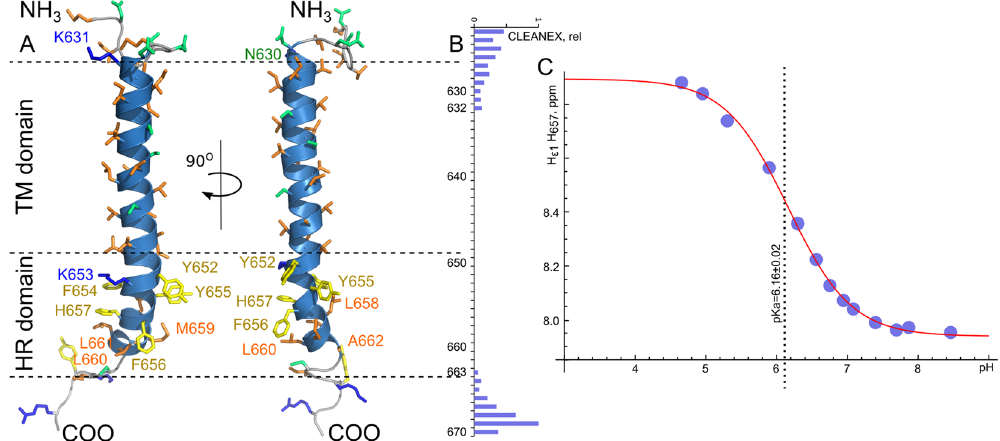
Figure 2. Spatial structure of TLR4-TMICL. ( A ) NMR-derived spatial structure of TLR4-TMICL in DMPG/ DHPC q = 0.4 bicelles, pH 6.0, LPR 200. Residues in the hydrophobic part of the ICL region of the protein are indicated and painted according to their physical properties: Hydrophobic by orange, aromatic by yellow, polar by green and positively charged – by blue. ( B ) relative rates of the amide protons exchange with the solvent, as measured in the CLEANEX experiment 26 for the TLR4-TMICL in DMPG/DHPC q = 0.4 bicelles at pH 7.2. ( C ) Dependence of the H ε 1 chemical shift of H657 on the ambient pH which was used to determine the corresponding pKa. The fit of the obtained data to the equation (1) is shown by the red solid line.